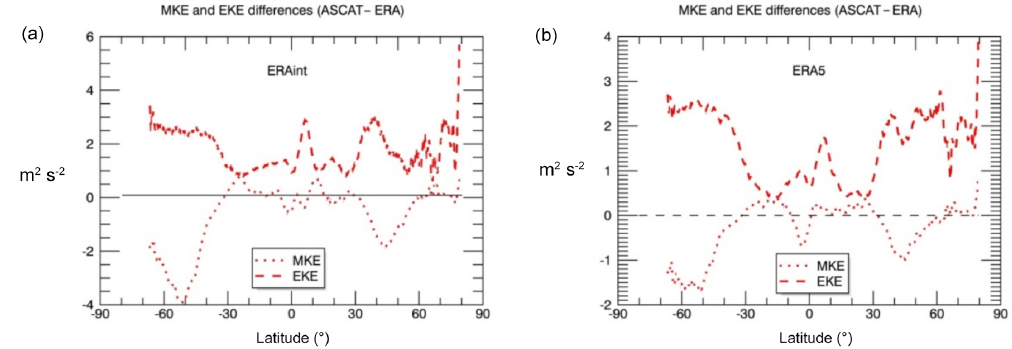
Figure 2. (a) Zonally averaged differences in mean kinetic energy (MKE; dots) and eddy kinetic energy (EKE; dashes) between ASCAT observations and ERA-Interim (a) and ERA5 (b) first-guess winds over